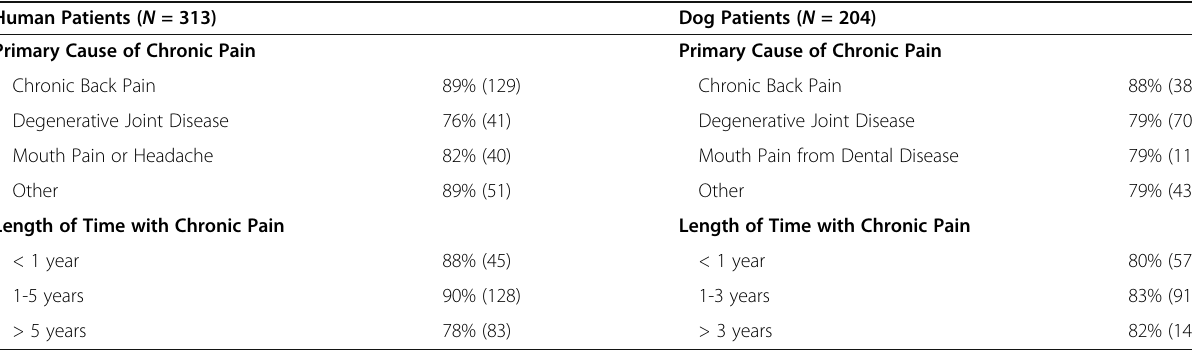
Table 5 Percentages of Respondents Who Felt their Expectations were Met by Cause and Length of Time with Chronic Pain Human Patients ( N = 313)